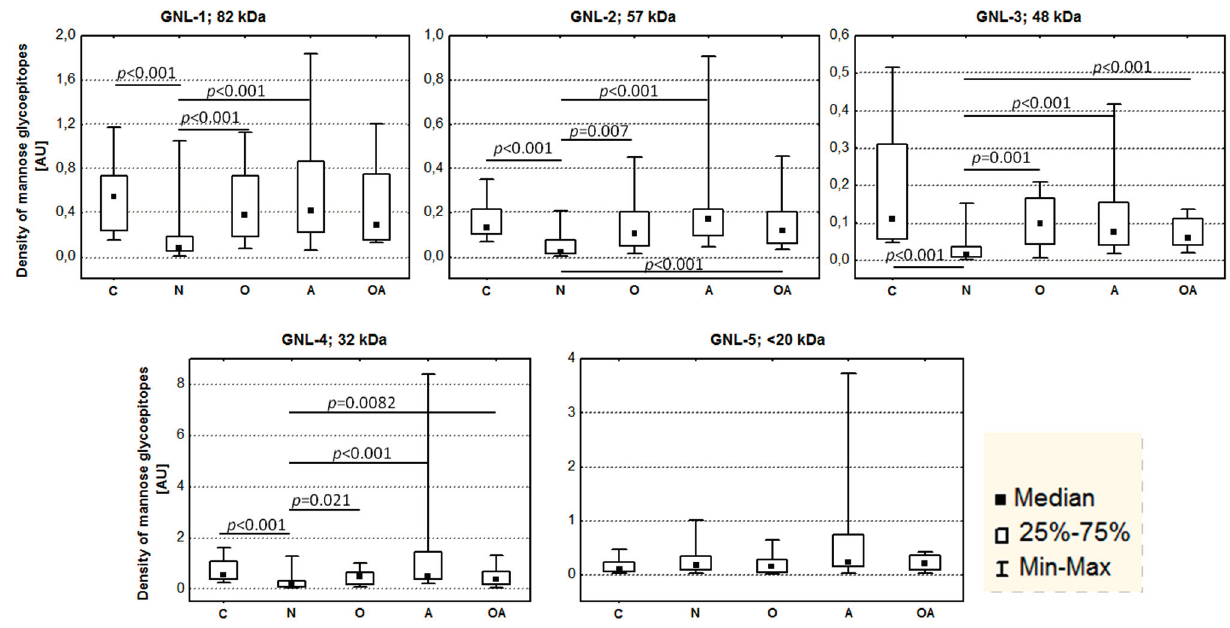
Figure 3. Density of mannose glycoepitopes in seminal plasma glycoproteins.